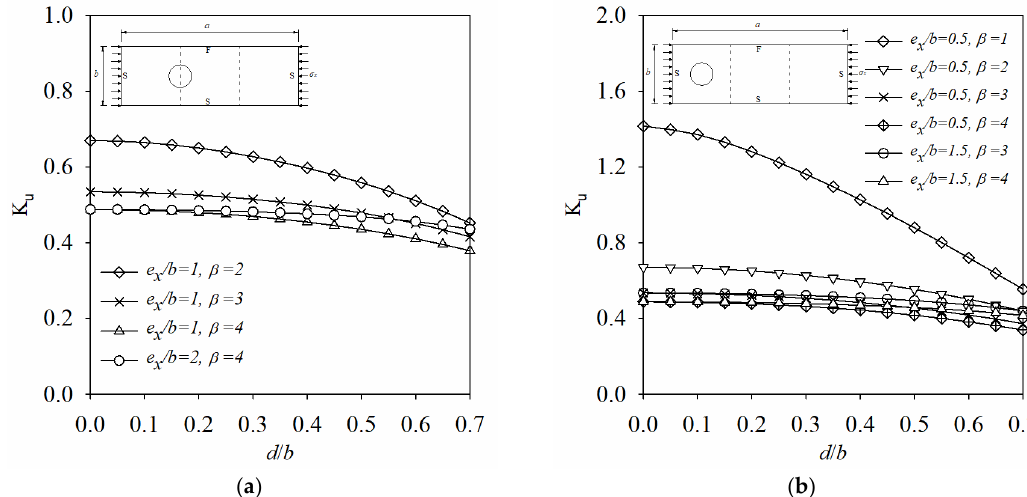
Figure 21. K u vs. d / b with BCs of 3S1F. ( a ): e x / b = 1 and 2; ( b ): e x / b = 0.5 and 1.5.